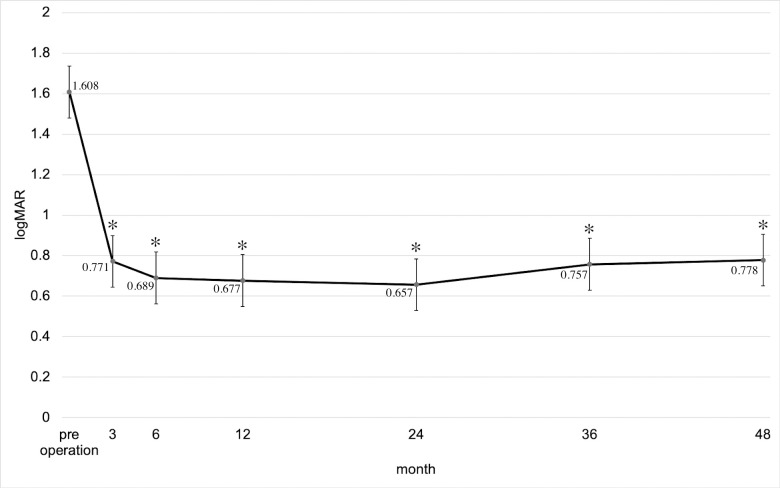
Transition and change in the amount of postoperative visual acuity.Mean BCVA (logMAR) ± standard error of the means (± SEM) during the preoperative period and 3 months, 6 months, 1 year, 2 years, 3 years, and 4 years after the primary vitrectomy. *P < 0.001 compared with preoperative mean BCVA (logMAR) based on the ANOVA test with Bonferroni correction.